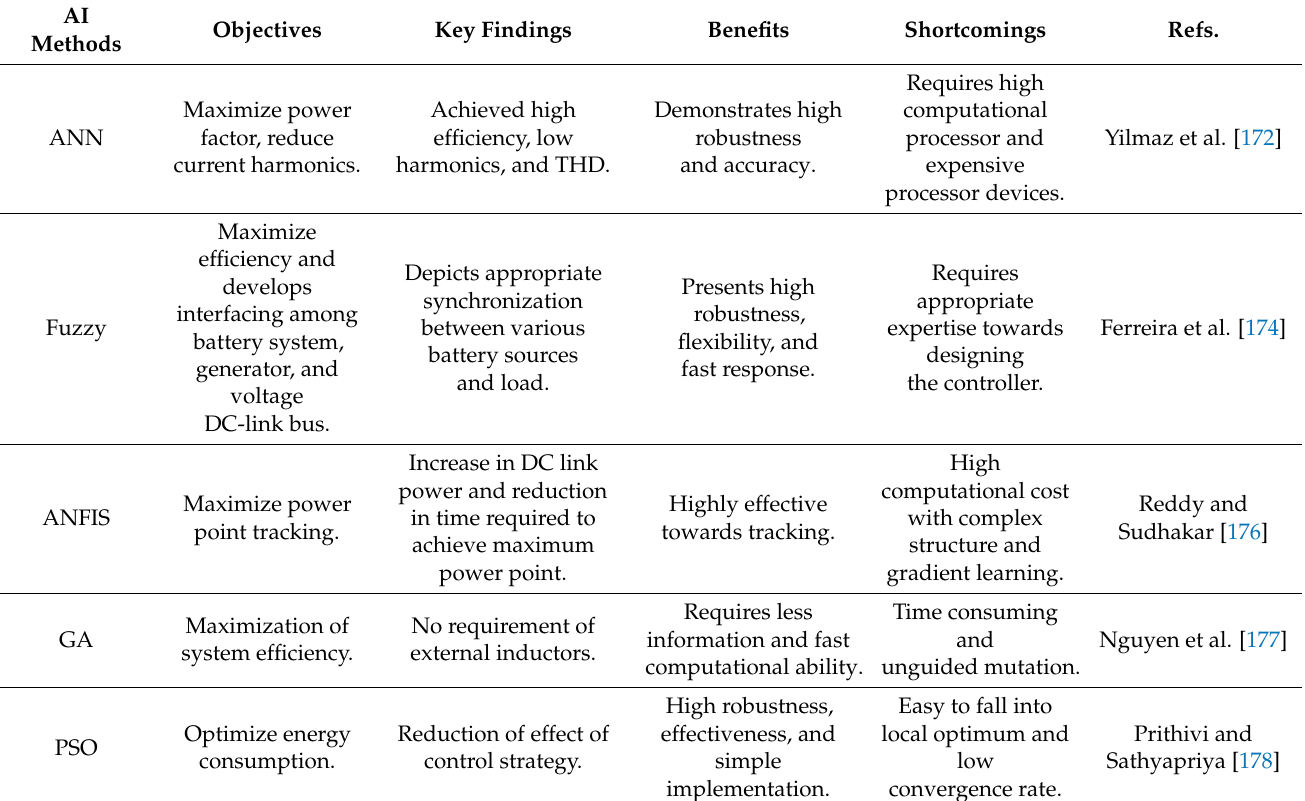
AI methods in EV converters highlighting objectives, key findings, benefits, and